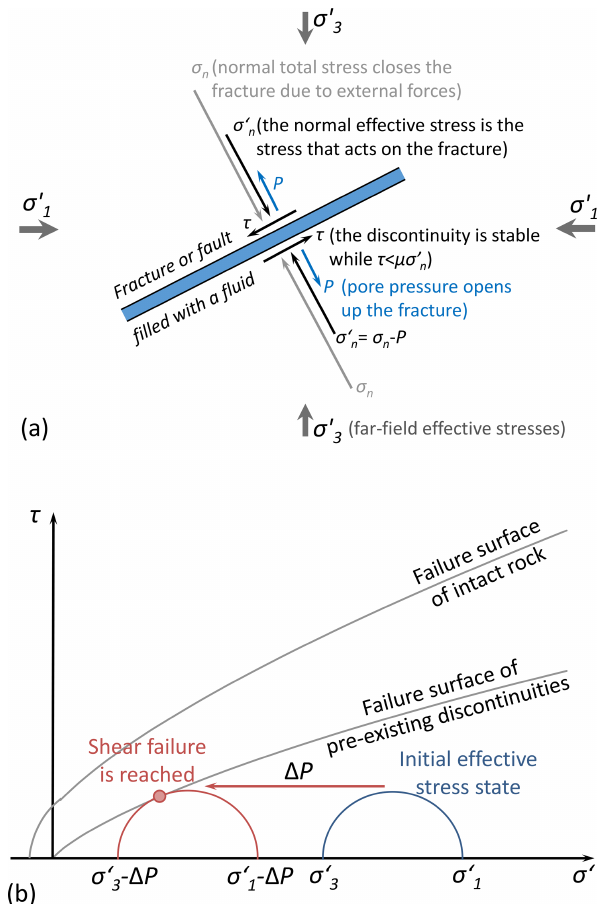
Figure 1. (a) Initial stress state of a fracture or fault of arbitrary ori- entation with respect to the far-field effective stress and (b) Mohr circles showing how the reduction in effective stresses as a result of pressure buildup, (cid:49)P , may induce shear failure in pre-existing discontinuities, i.e., fractures or faults. σ (cid:48) and σ (cid:48) are the maximum 1 3 and minimum principal effective stresses, respectively, τ is tangen- tial stress, σ (cid:48) n is normal effective stress to the fracture or fault, and µ is the friction coefficient. The failure surface has been plotted by considering the nonlinear failure criterion (Barton,